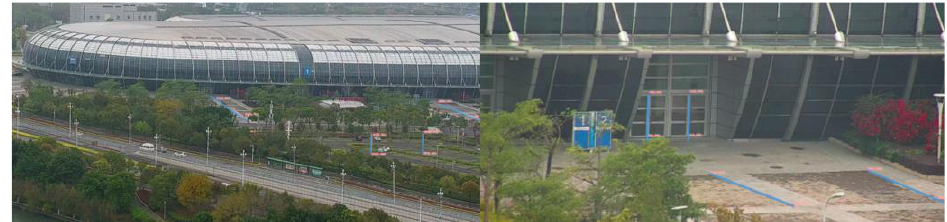
Figure 10. Collecting parallel lines to calculate vanishing point.